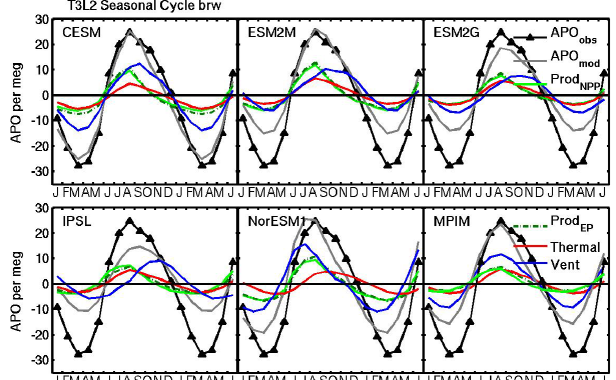
Figure 4. Partitioning of the model mean APO cycle into NCP, ther- mal and residual ventilation components at Barrow, Alaska. The APO NCP components are estimated alternatively based on ocean model EP at 100m (Prod EP light green, solid curve) and vertically integrated NPP (Prod NPP ) scaled by the mean ratio of EP 100 / NPP ( f ratio) between 40 and 60 ◦ N of the given ocean model (dark green, dashed curve). All components were translated into atmo- spheric signals as described in Sect. 2.2.3. Also shown is APO vent (blue), calculated as a residual of APO – APO NCP – APO therm . With the exception of observed APO, all curves reflect the unscaled mean of the 13 ATMs used in the matrix